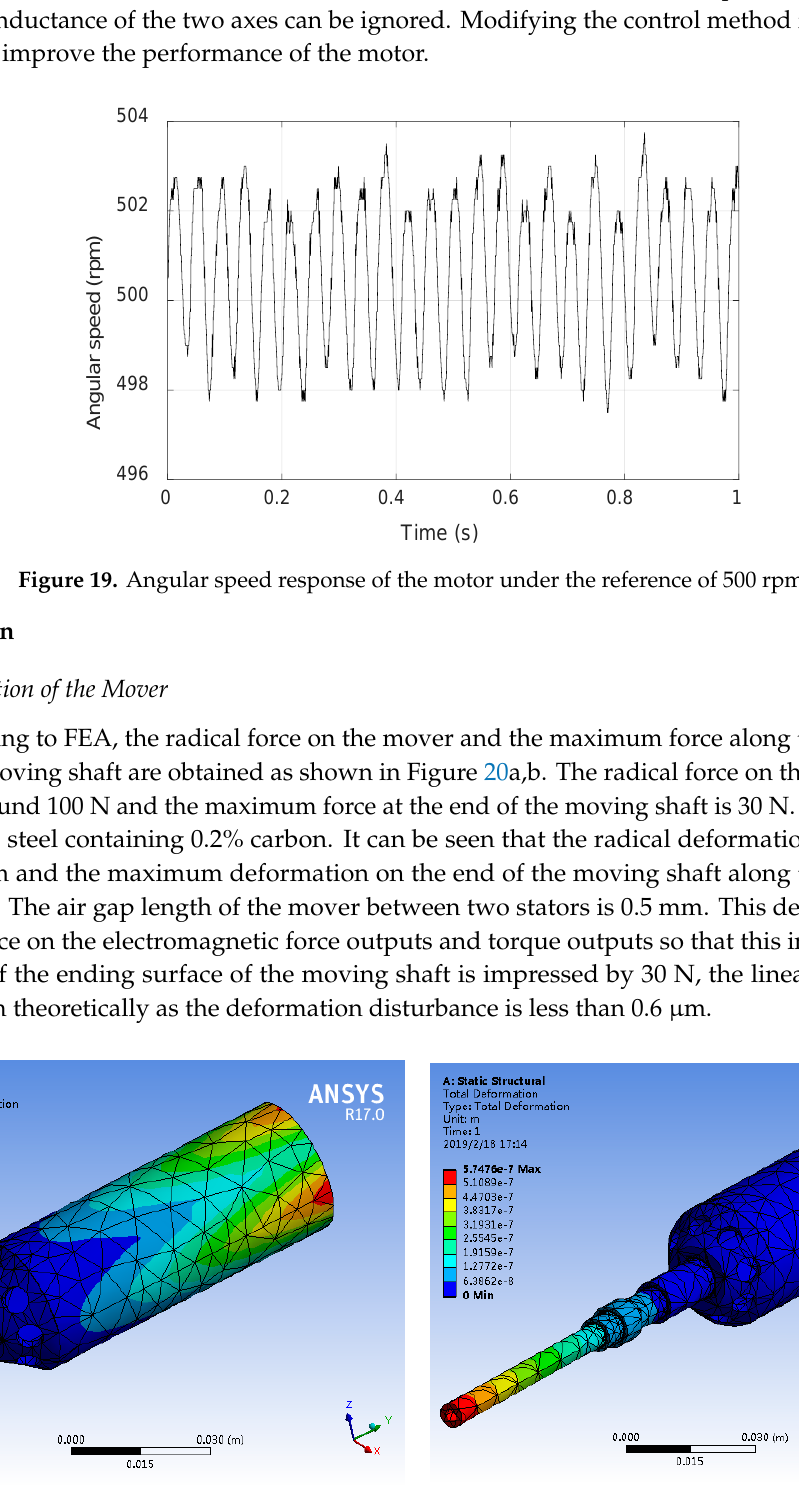
( a ) Radical deformation of the mover. ( b ) Deformation at the end of the shaft. Figure 20. Deformation of the mover in the radium direction ( a ) and along the shaft direction ( b ).